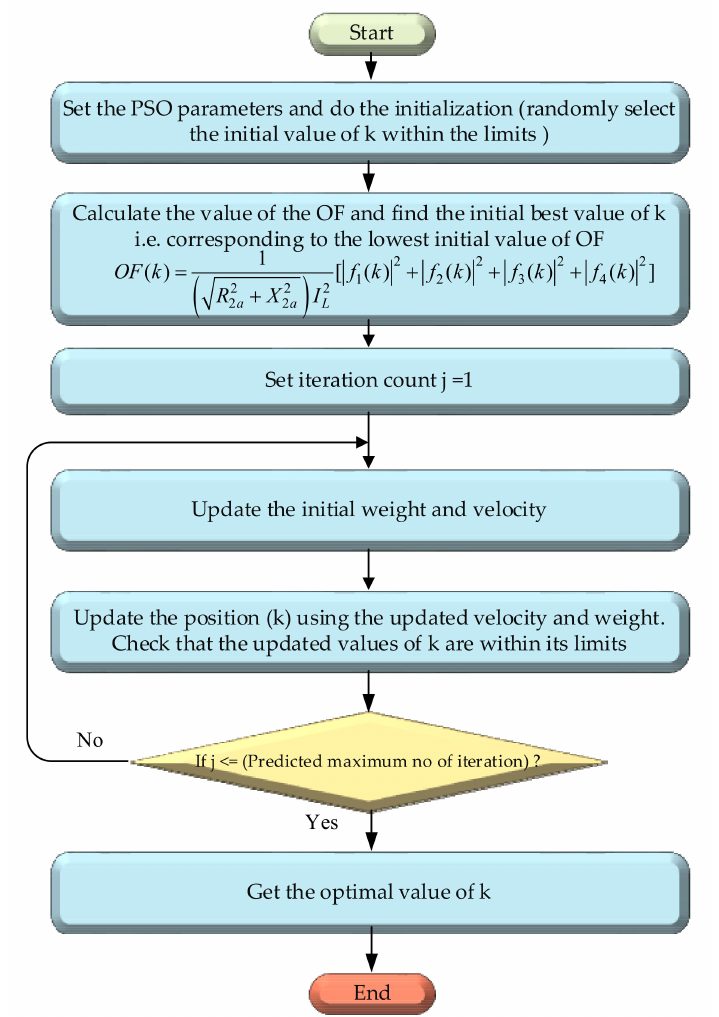
Figure 16. Flowchart of PSO applied for finding the best value of k .